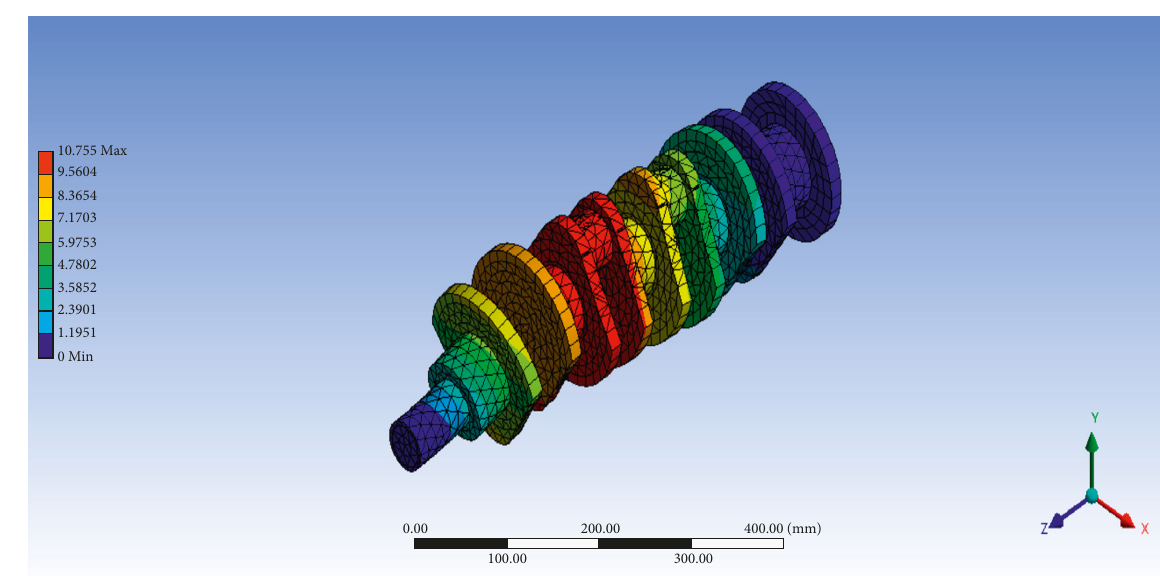
Figure 17: Deformation of FGM crankshaft at the first mode of